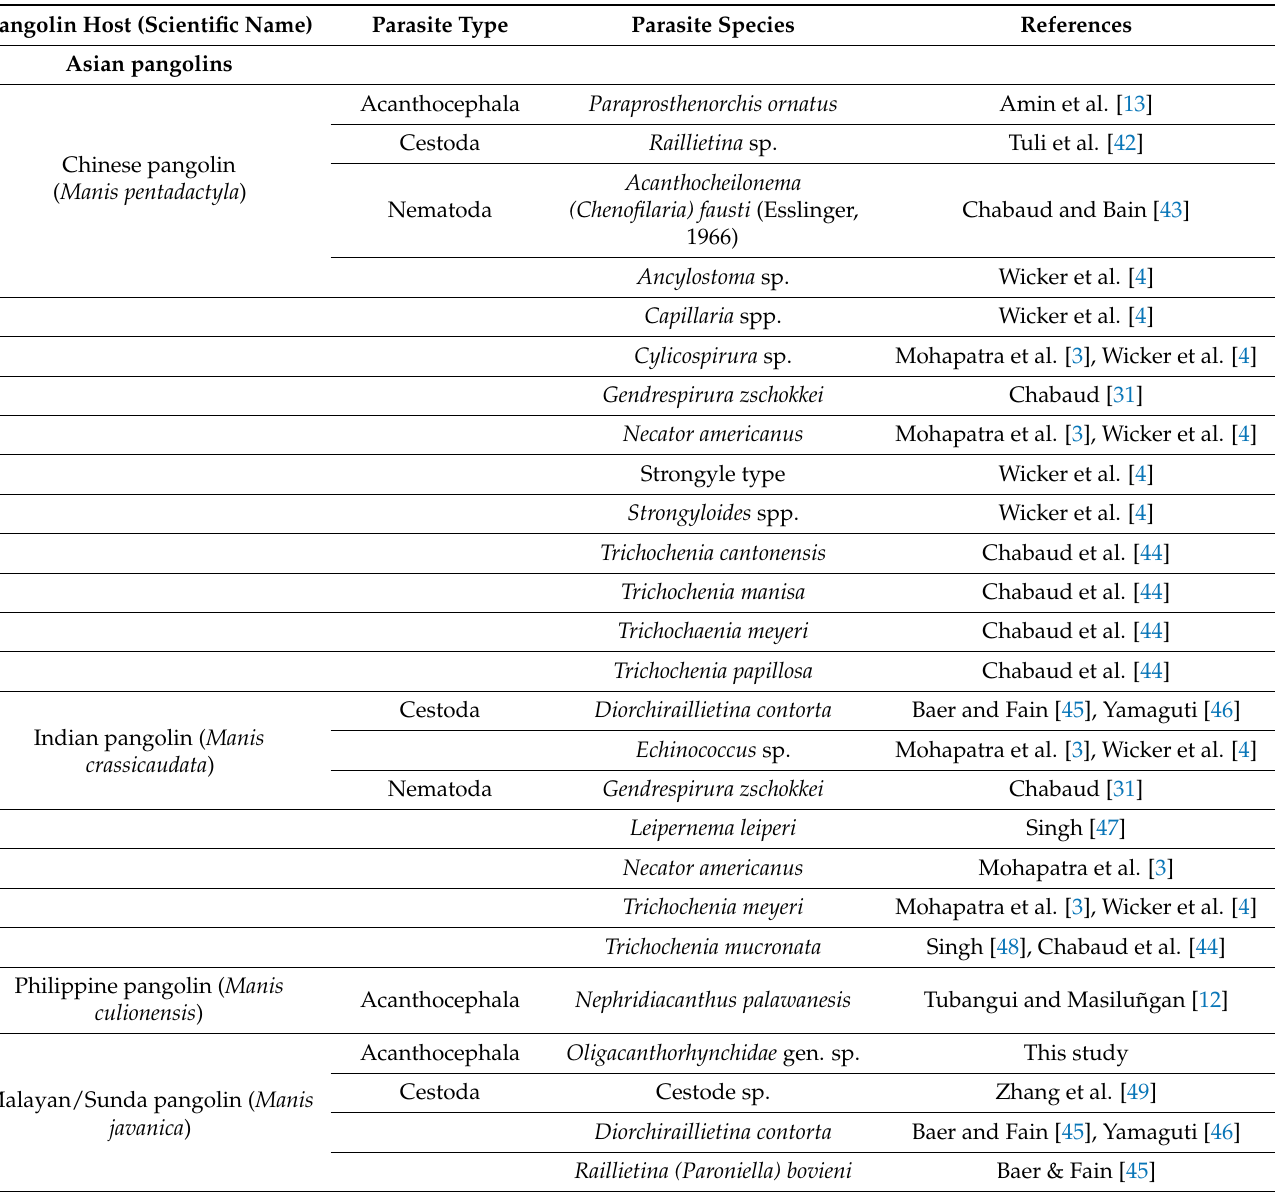
Table 4. An updated checklist of helminths and pentastomes of pangolins. Note that the protozoans, ectoparasites and bacteria listed in Mohapatra et al. [3] and Wicker et al. [4] have not been included in this update. If there are no changes from the list as presented in Mohapatra et al. [3] and/or Wicker et al. [4], that is the reference listed; see Mohapatra et al. [3] and/or Wicker et al. [4] for the specific references to those